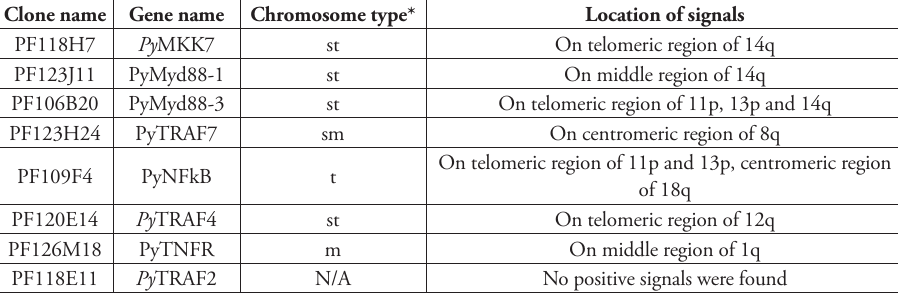
Table 1. Information of genes and fosmid clones and FISH mapping results.